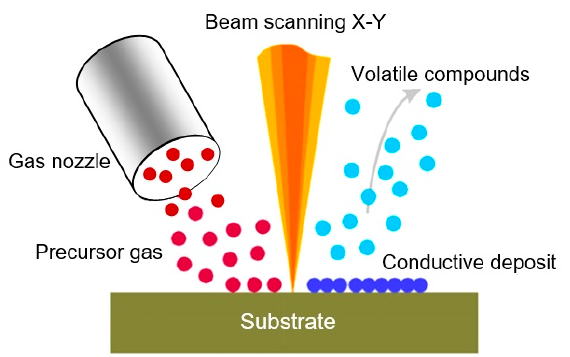
Figure 13. Schematic representation of local deposition, assisted by the focused ion beam (FIB). The gas precursor introduced by the capillary is decomposed by the secondary electrons generated by the interaction of the primary ion beam with the target. Reproduced with permission from Gierak [237].